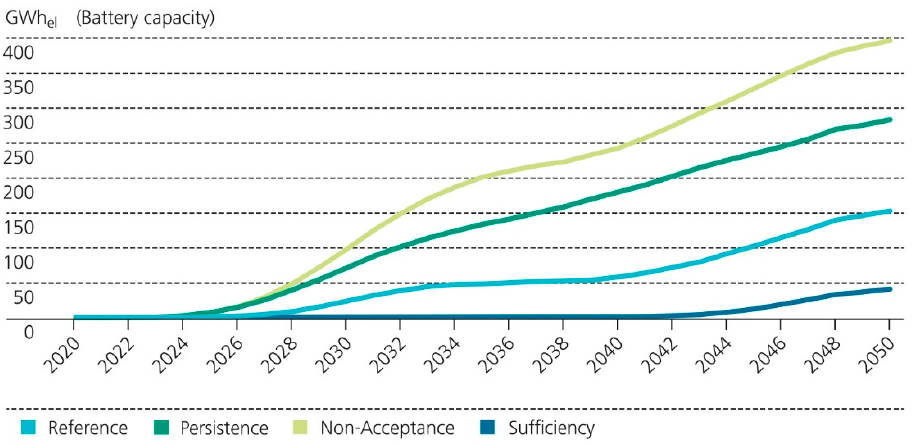
Figure 5. Installed capacity of stationary batteries in Germany for all calculated scenarios.